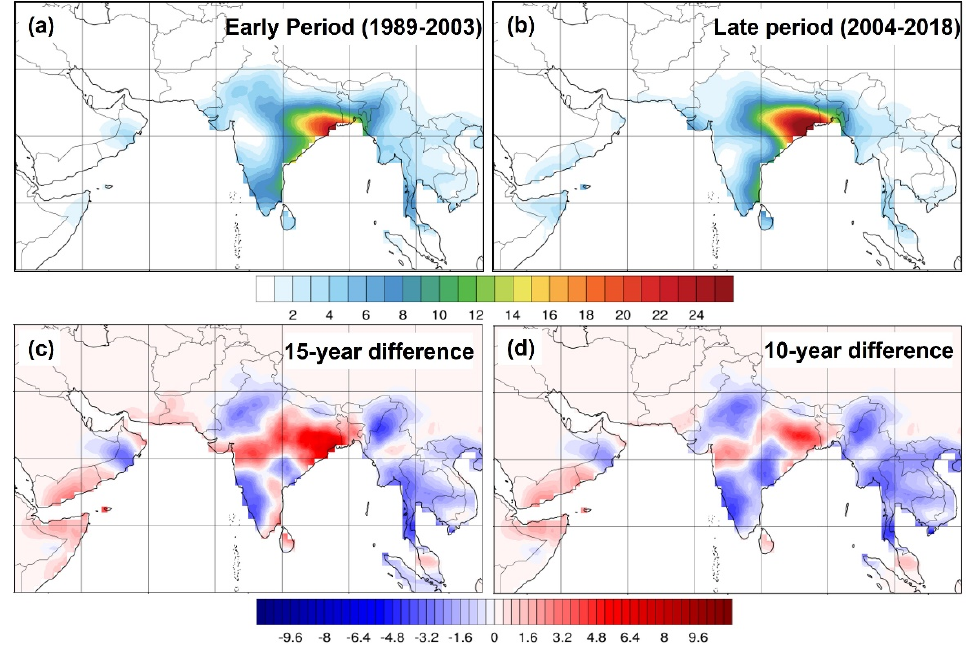
Figure 5. Landfalling TC Track Density for ( a ) the Early Period (1989–2003); ( b ) the Late period (2004–2018); ( c ) the difference between the Early and Late periods; and ( d ) the difference calculated using 10-year periods 2009–2018 minus 1989–1998 to demonstrate the sensitivity to periods chosen. Density Maps are calculated at 0.1° resolution .